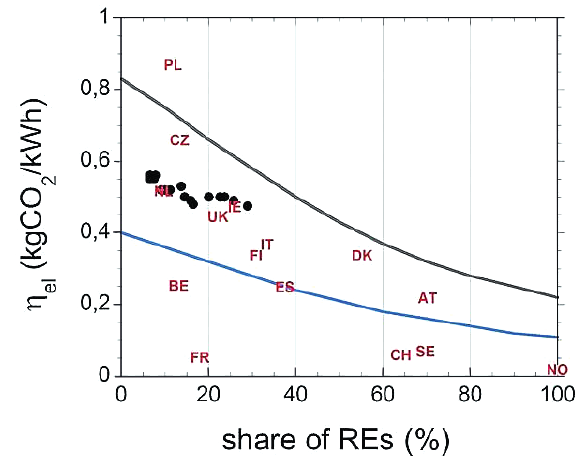
Fig. 8. – Specific CO 2 emission versus the share of renewable energies involved in electricity generation. Black dots: German development from 2002 to 2015. The black curve represents an upper limit —Germany’s electricity is produced with the present mix of fossil fuels. The blue curve represents the case that Germany’s electricity is produced by gas. The country symbols represent the situation of different European